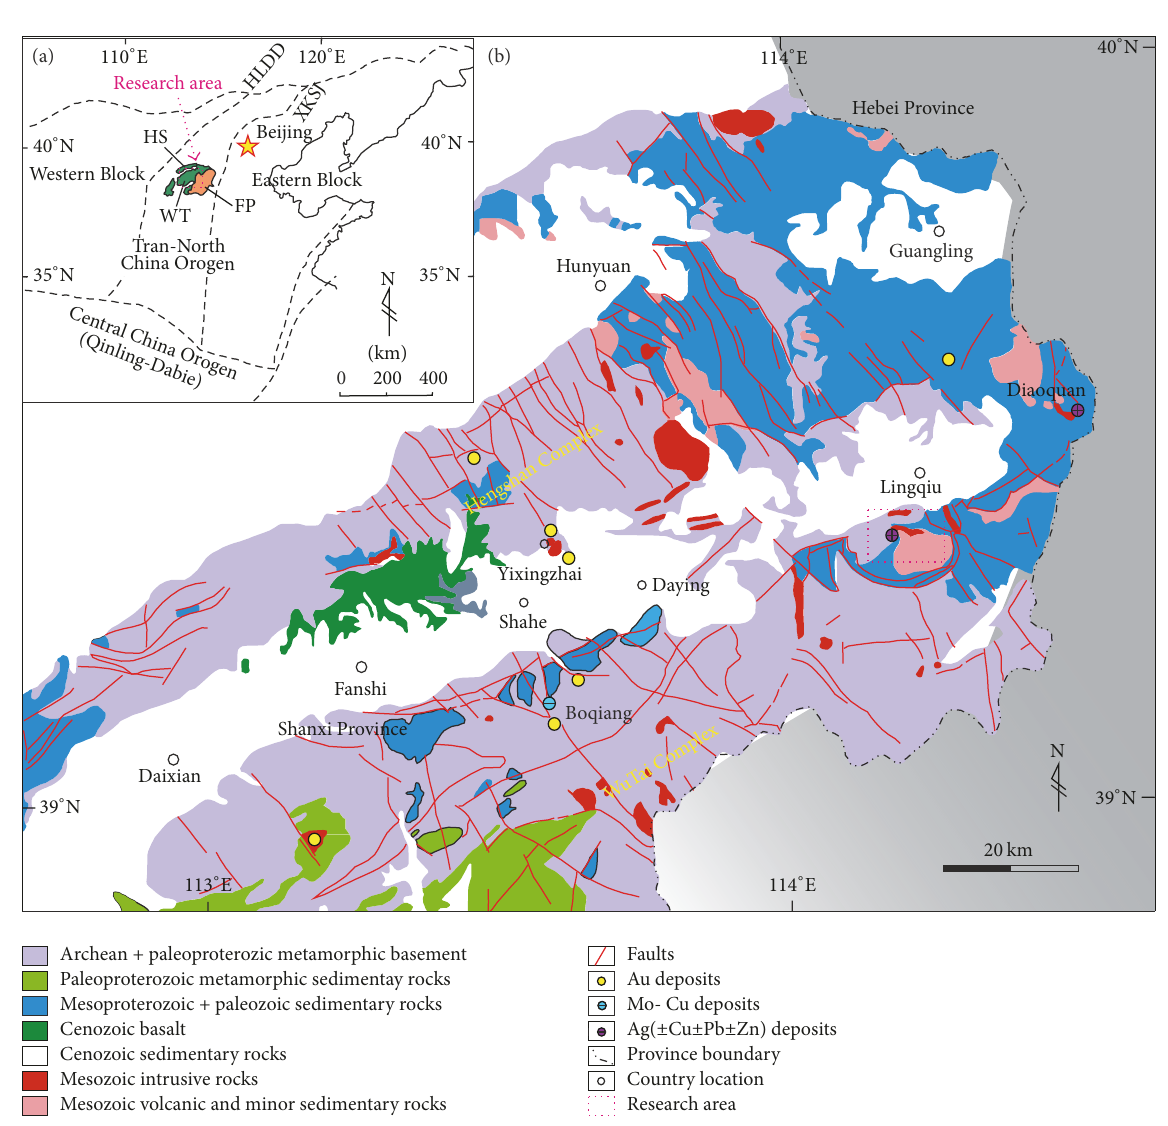
Figure 1: (a) Location of the study area in the central North China Craton (modified from [33]); (b) simplified tectonic map showing the distribution of metamorphic complexes in the Wutai-Hengshan region (modified from [12]). WT, Wutai Complex; FP, Fuping Complex; HS, Hengshan Complex; HLDD, Huashan-Lishi-Datong-Duolun Fault; XKSJ, Xinyang-Kaifeng-Shijiazhuang-Jianping